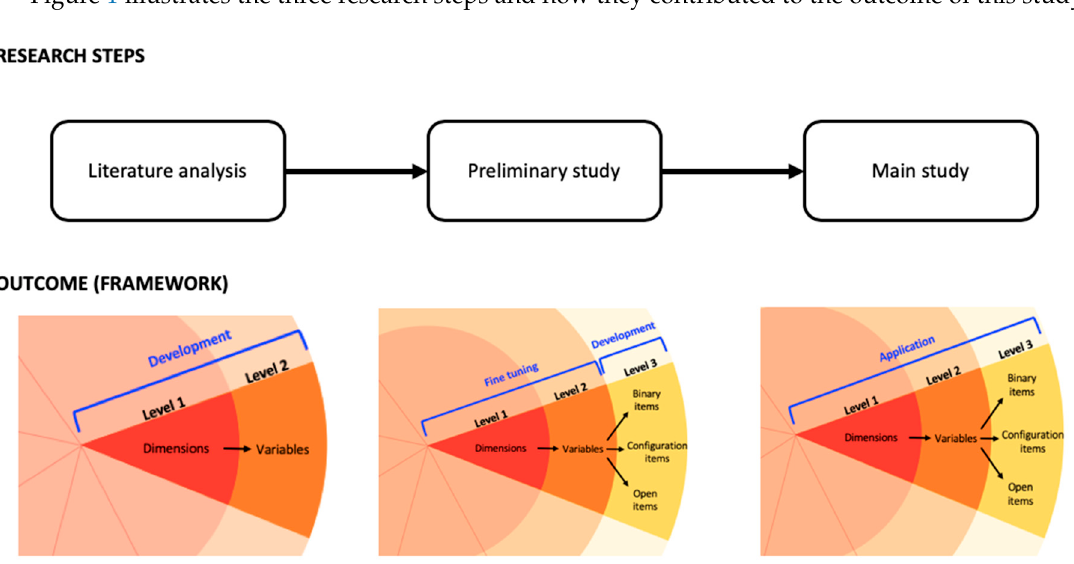
Table 3. Case studies description.